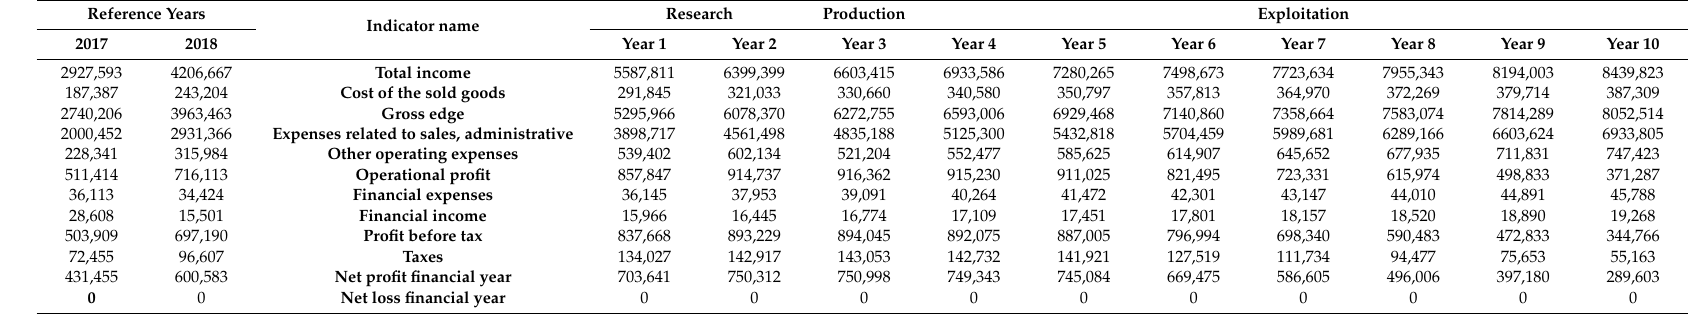
Table 4. Profit and loss account for the current